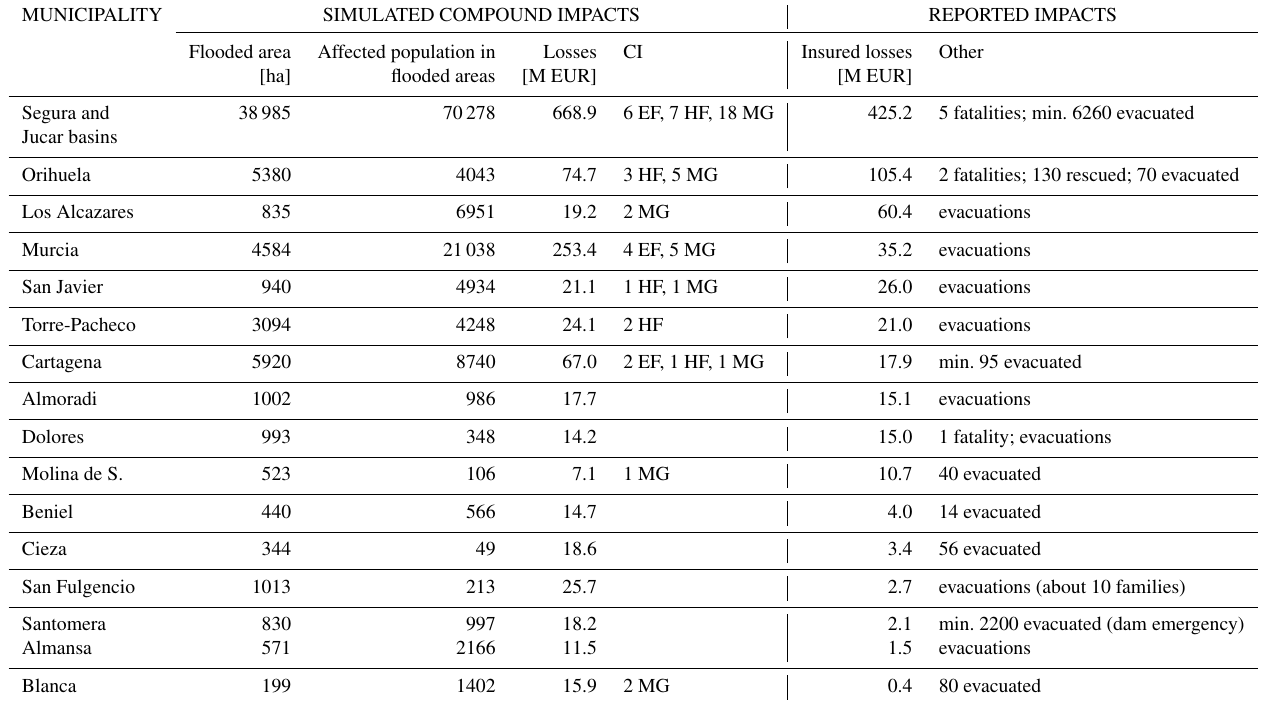
Table 4. Summary of simulated and reported compound flood impacts in the 15 municipalities with more than EUR10 million in simulated or insured losses (corresponding to Fig. 9). Critical infrastructure (CI) categorised as education facilities (EF), health facilities (HF), and mass-gathering sites